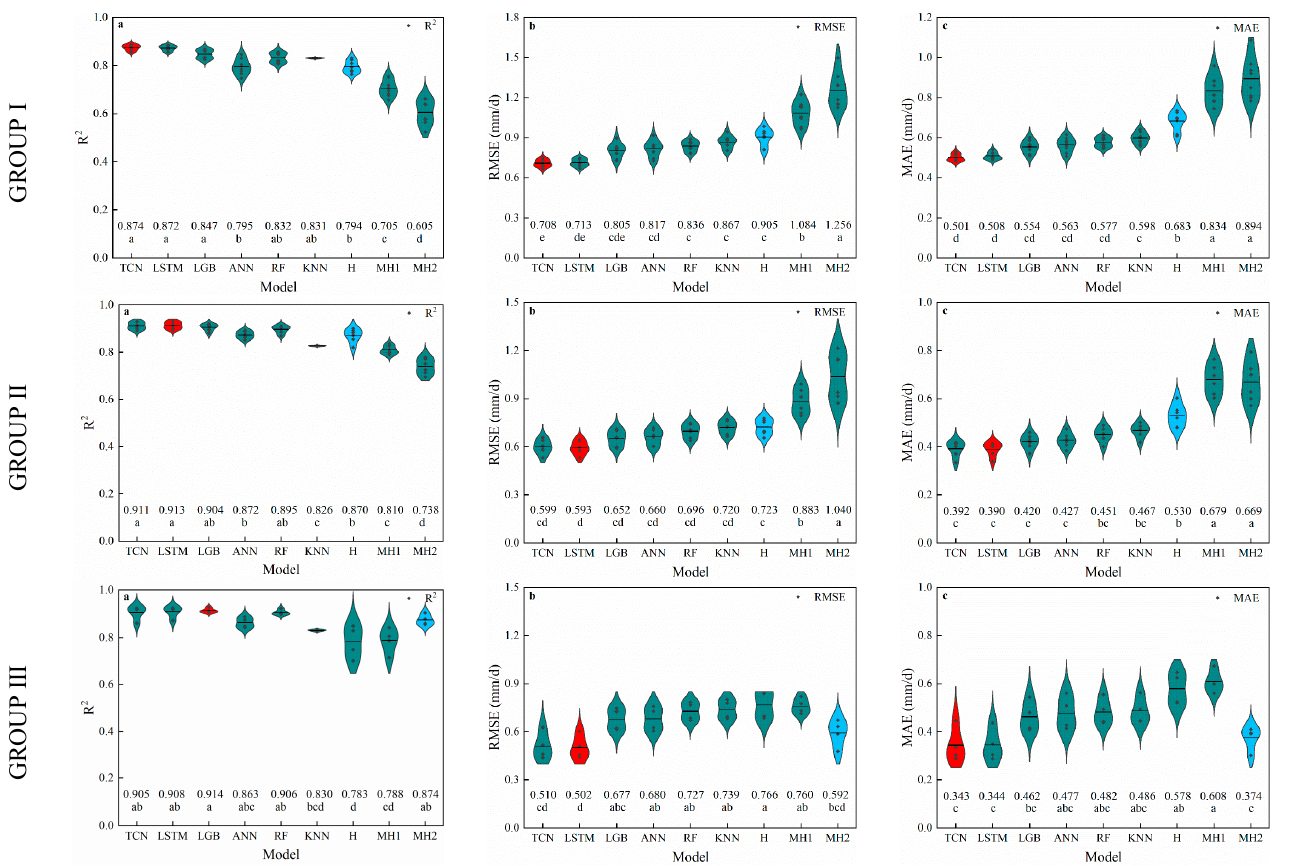
Figure 4. The performance of the temperature-based models during the second strategy: ( a ) deter- mination coefficient (R 2 ), ( b ) root mean square error (RMSE), and ( c ) mean absolute error (MAE).